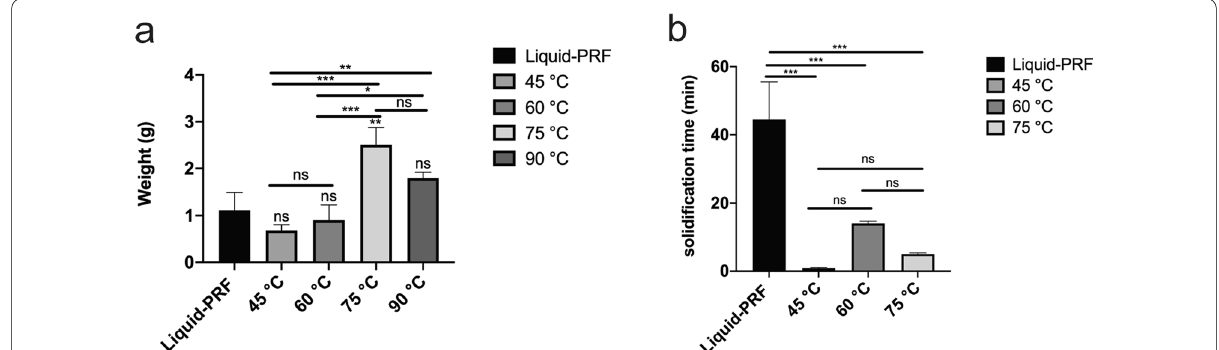
Fig. 2 Weight and solidification time of H-PRF